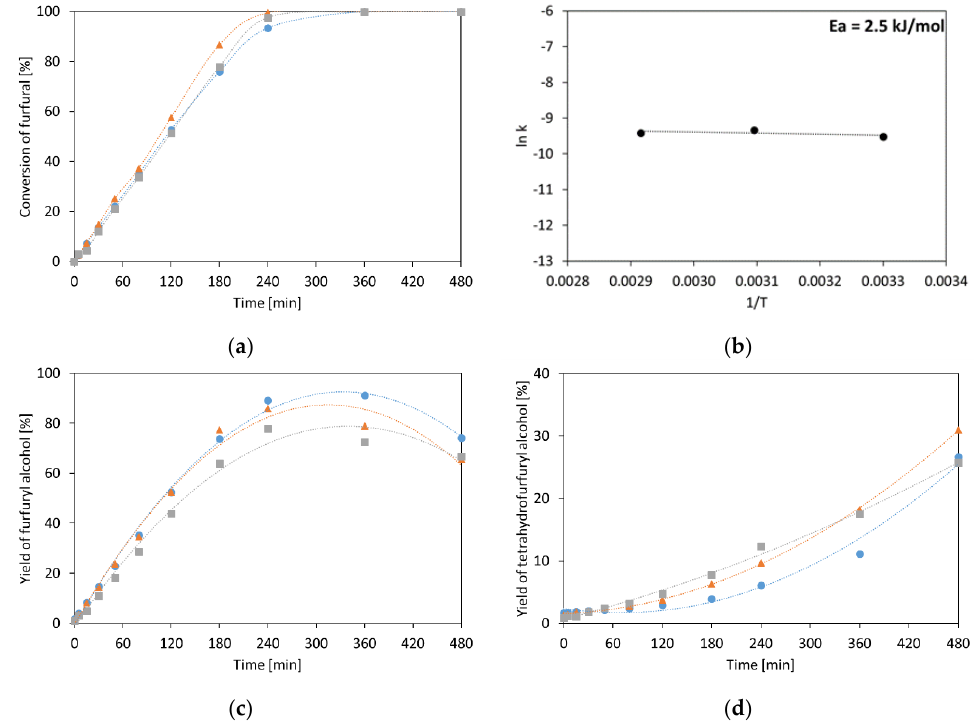
Figure 2. ( a ) Conversion of furfural, ( b ) Arrhenius plot. Yield of ( c ) furfuryl alcohol and ( d ) tetrahydrofurfuryl alcohol at 30, 50, and 70 °C.